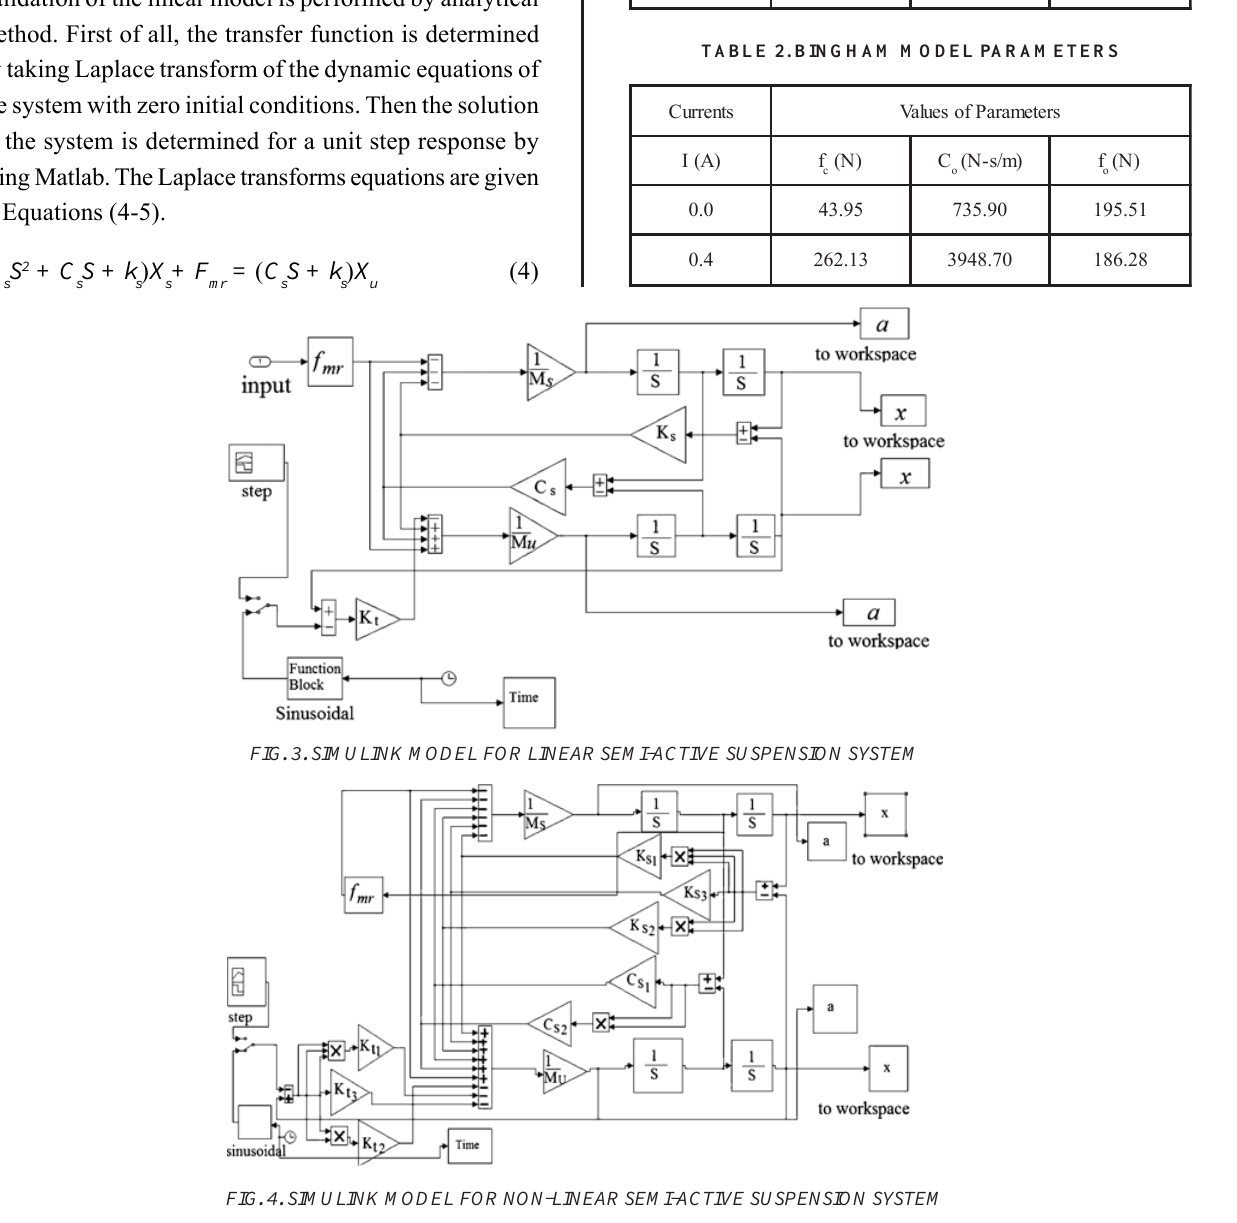
TABLE 2. BINGHAM MODEL